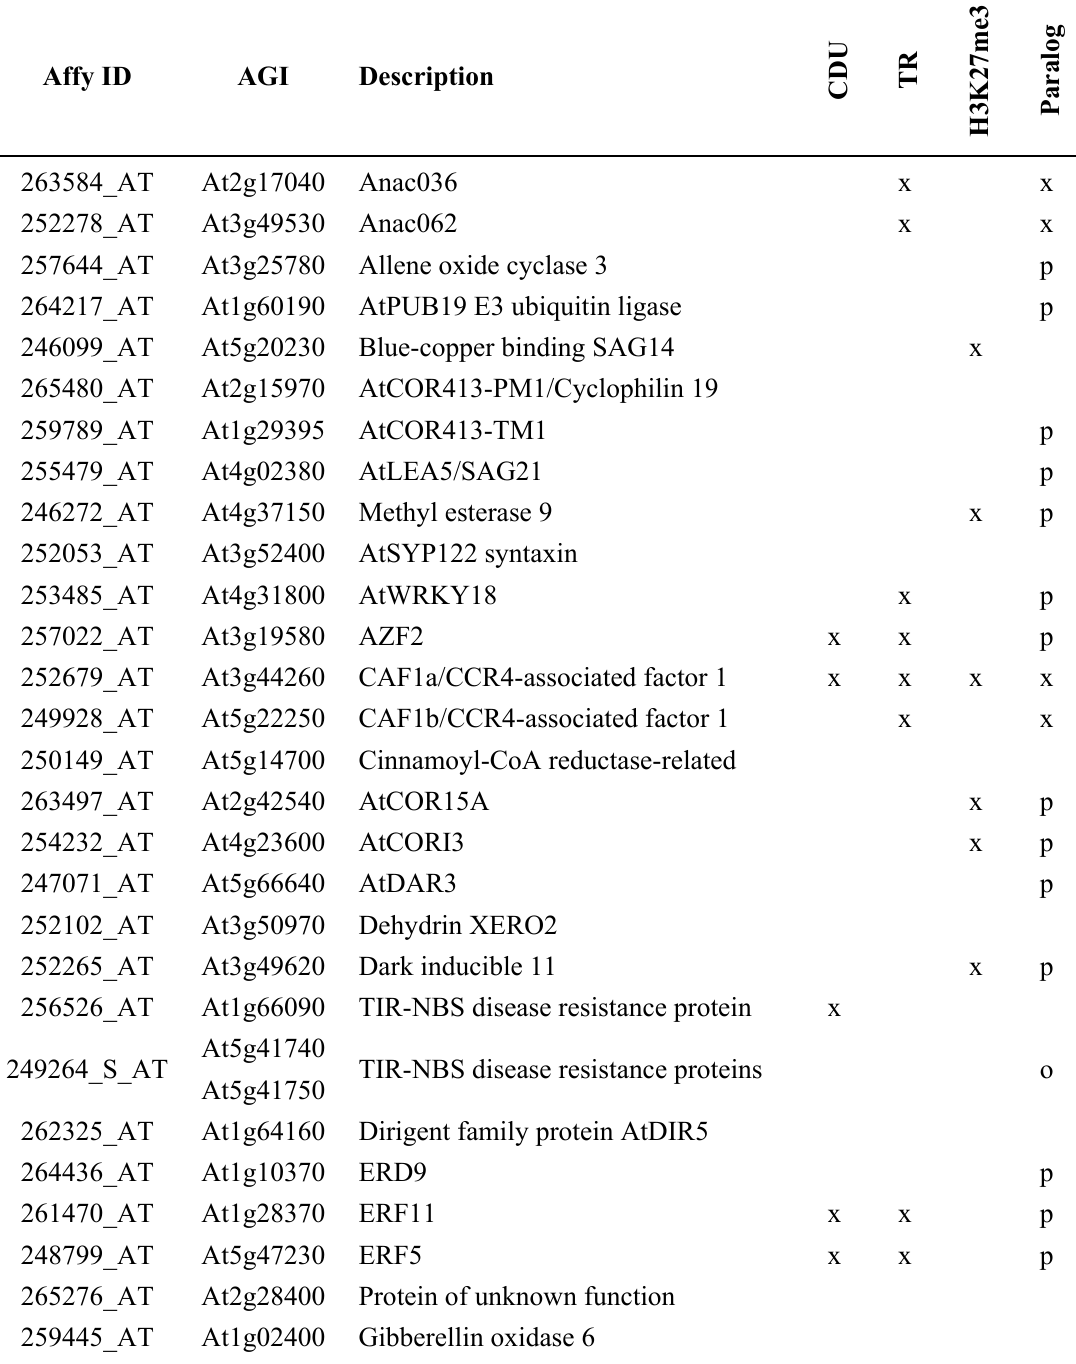
Table 3. The 56 genes of the plant core environmental stress response ( PCESR ). All genes are regulated during UV-B, osmotic, salt and wounding stress. CDU: genes that were previously proposed as PCESR genes [4] during cold, drought and UV-B (CDU) treatment. TR: gene products that are involved in the regulation of transcription (TR). H3K27me3: genes that are known targets for histone methylation in the shoot [46,47]; Paralog: genes with paralogs contained in the list (x), genes that have paralogs in the genome (p), probes that identify paralogous genes